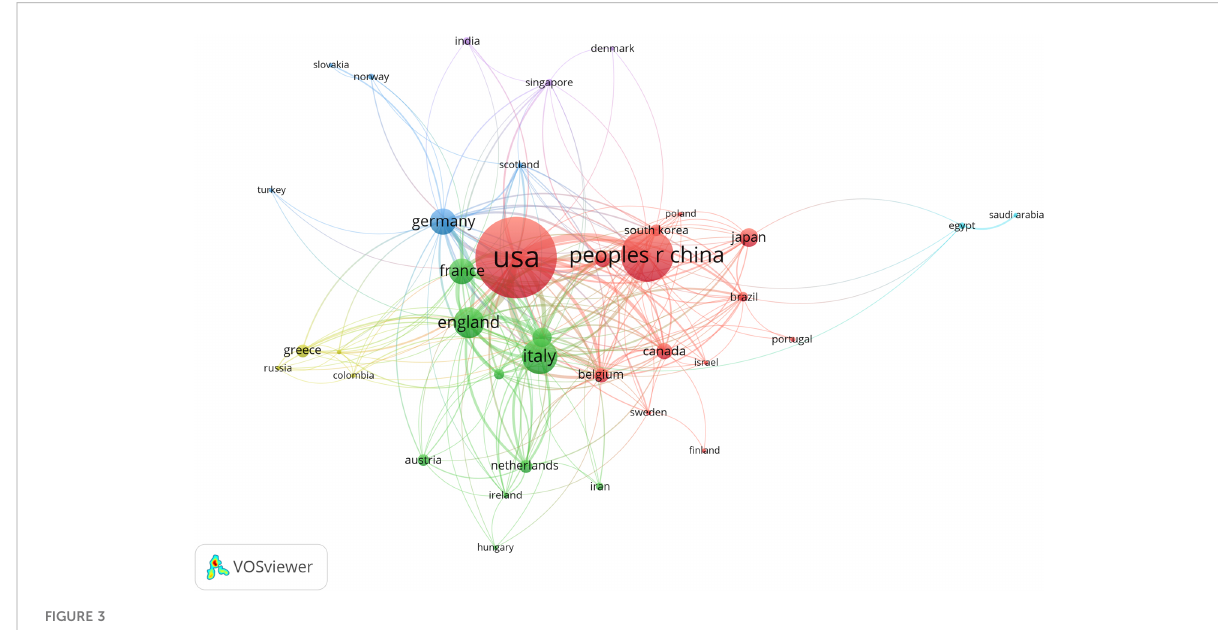
FIGURE 3 Co-authorships analysis of countries in network visualization